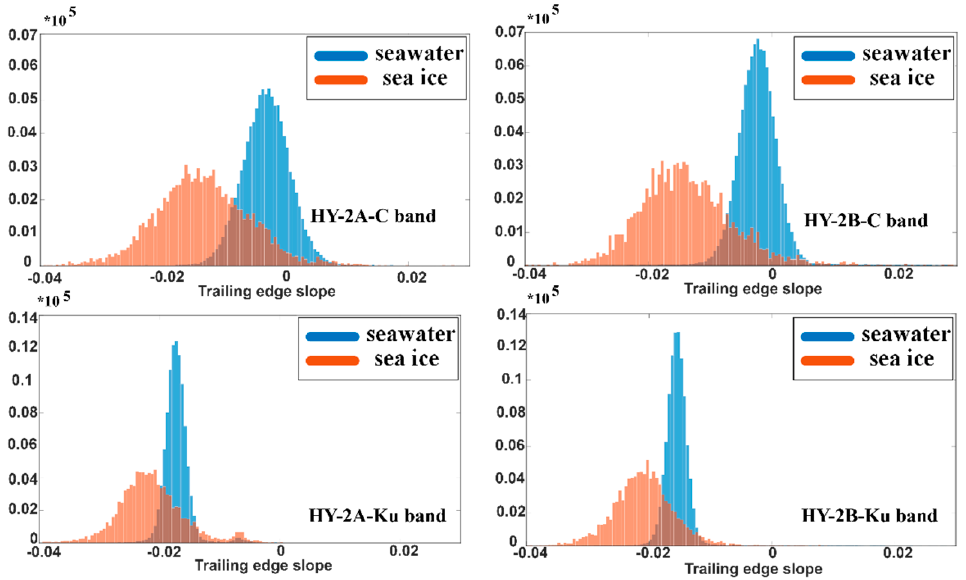
Figure 14. Histogram of the trailing edge slopes.